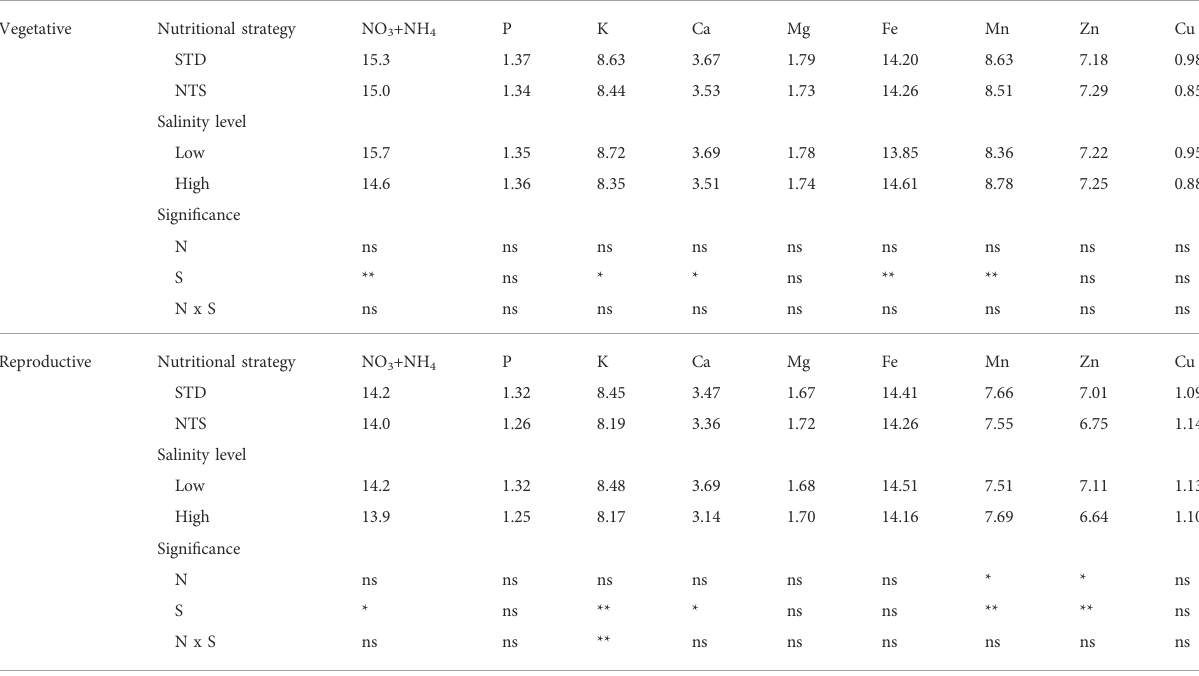
TABLE 1 Nutrient uptake concentrations (NO 3 +NH 4 , P, K, Ca, Mg, mmol L − 1 and Fe, Mn, Zn, Cu μ mol L − 1 ) in the vegetative and reproductive stage of hydroponic tomato crops supplied with nutrient solution compositions provided by two nutritional strategies (i.e., standard-STD and NUTRISENSE-NTS) under low- and high-salinity (NaCl) levels.